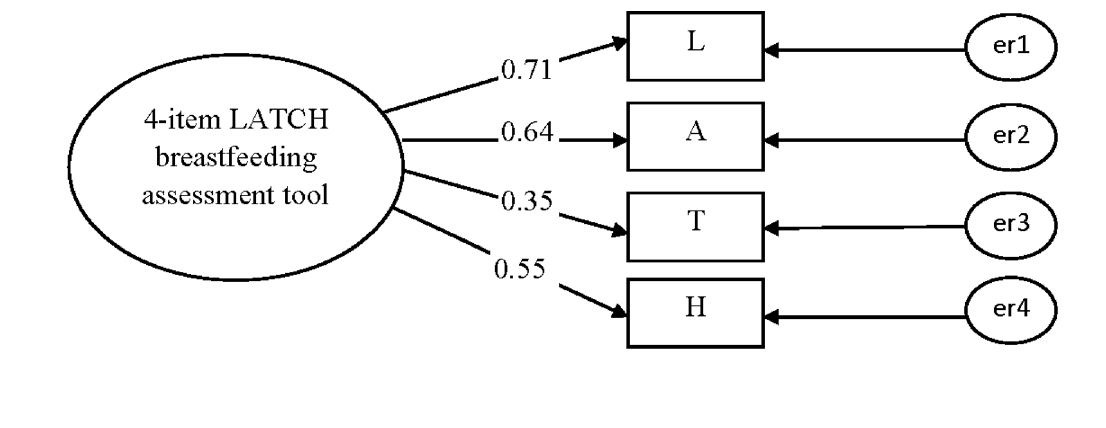
Fig 4. Confirmatory factor analysis for the 4-item LATCH breastfeeding assessment tool among caesarean delivered women (n = 238). Fit indices: GFI=0.994; AGFI=0.971; IFI=0.993; TLI=0.979; CFI=0.993; RMSEA=0.042.